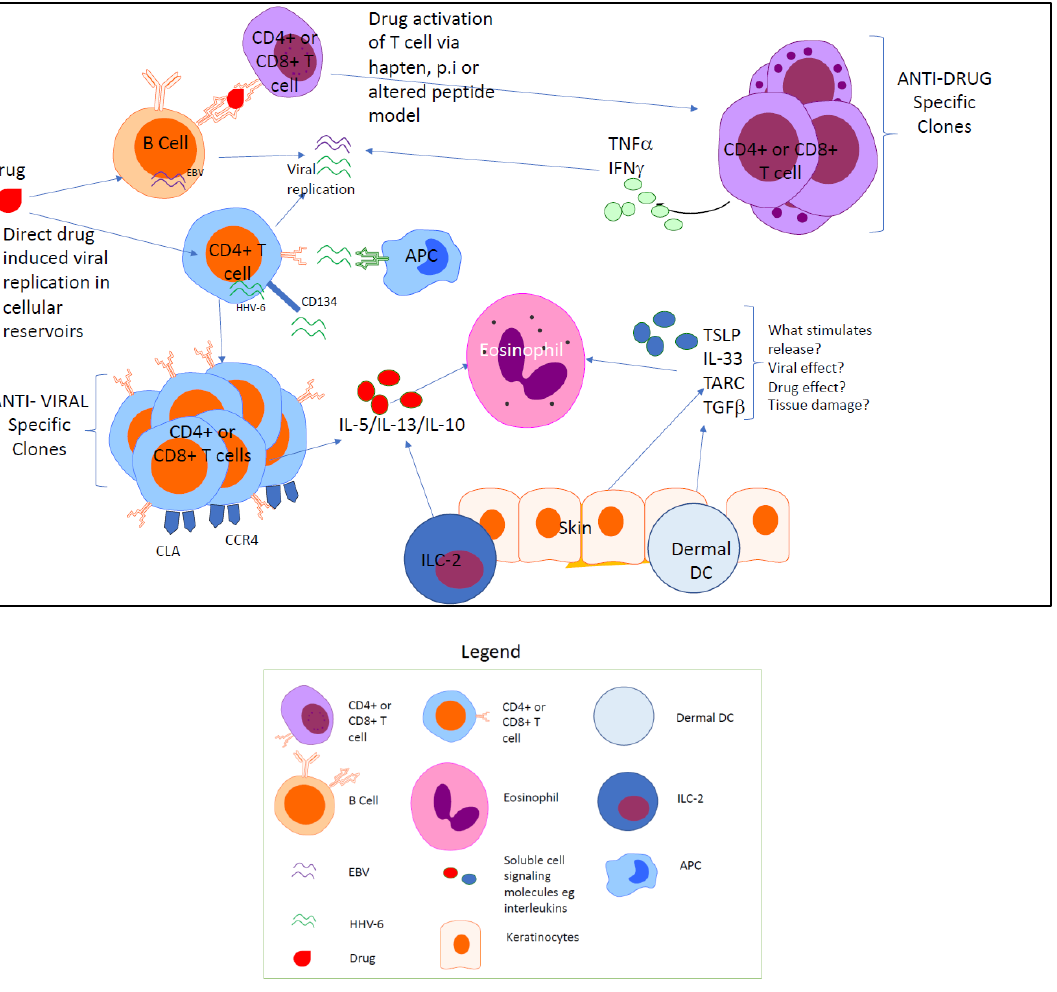
Figure 1. Postulated cell activation of DRESS pathophysiology.